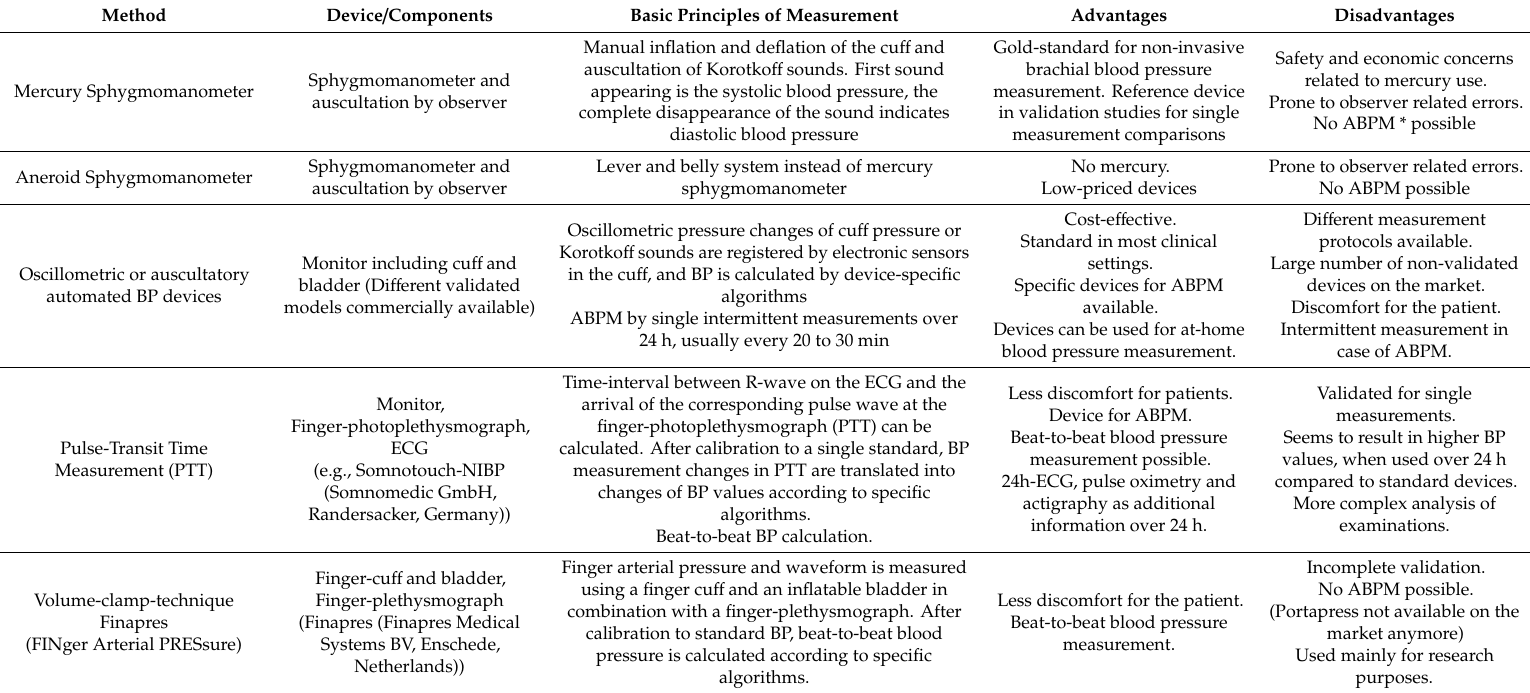
Table 1. Overview of di ff erent non-invasive methods for o ffi ce and out-of-o ffi ce blood pressure